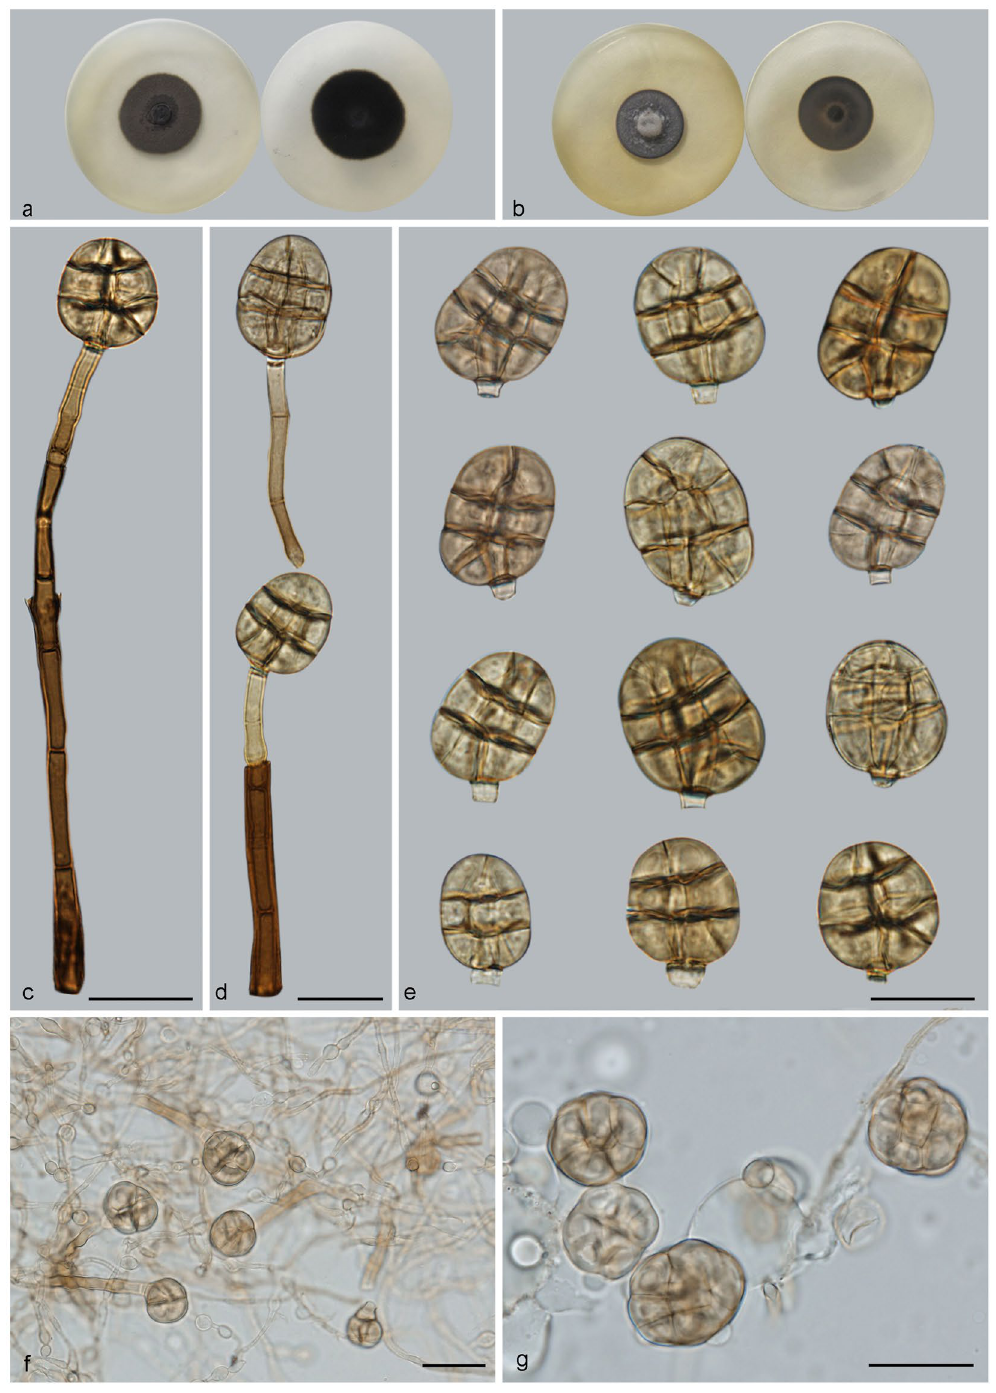
Figure 4. Acrodictys globulosa. ( a ) Colony on PDA (surface and reverse). ( b ) Colony on MEA (surface and reverse). ( c – e ) From natural substrate (HSAUP H4696): ( c , d ) Conidiophores with conidia, ( e ) Conidia. ( f , g ) From PDA (CGMCC 3.18644): Conidiophores and conidia. — Scale bars = 20 μ